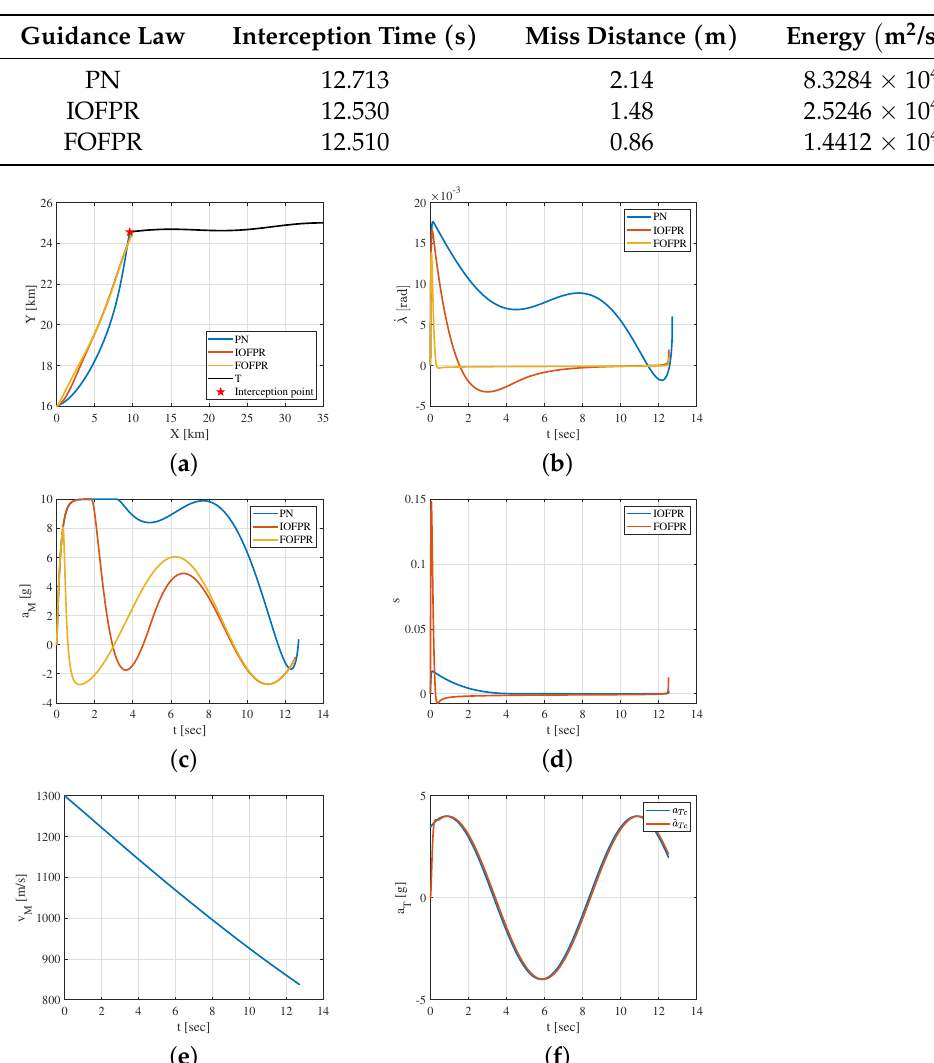
Table 6. Analysis of the sinusoidal maneuver mode.